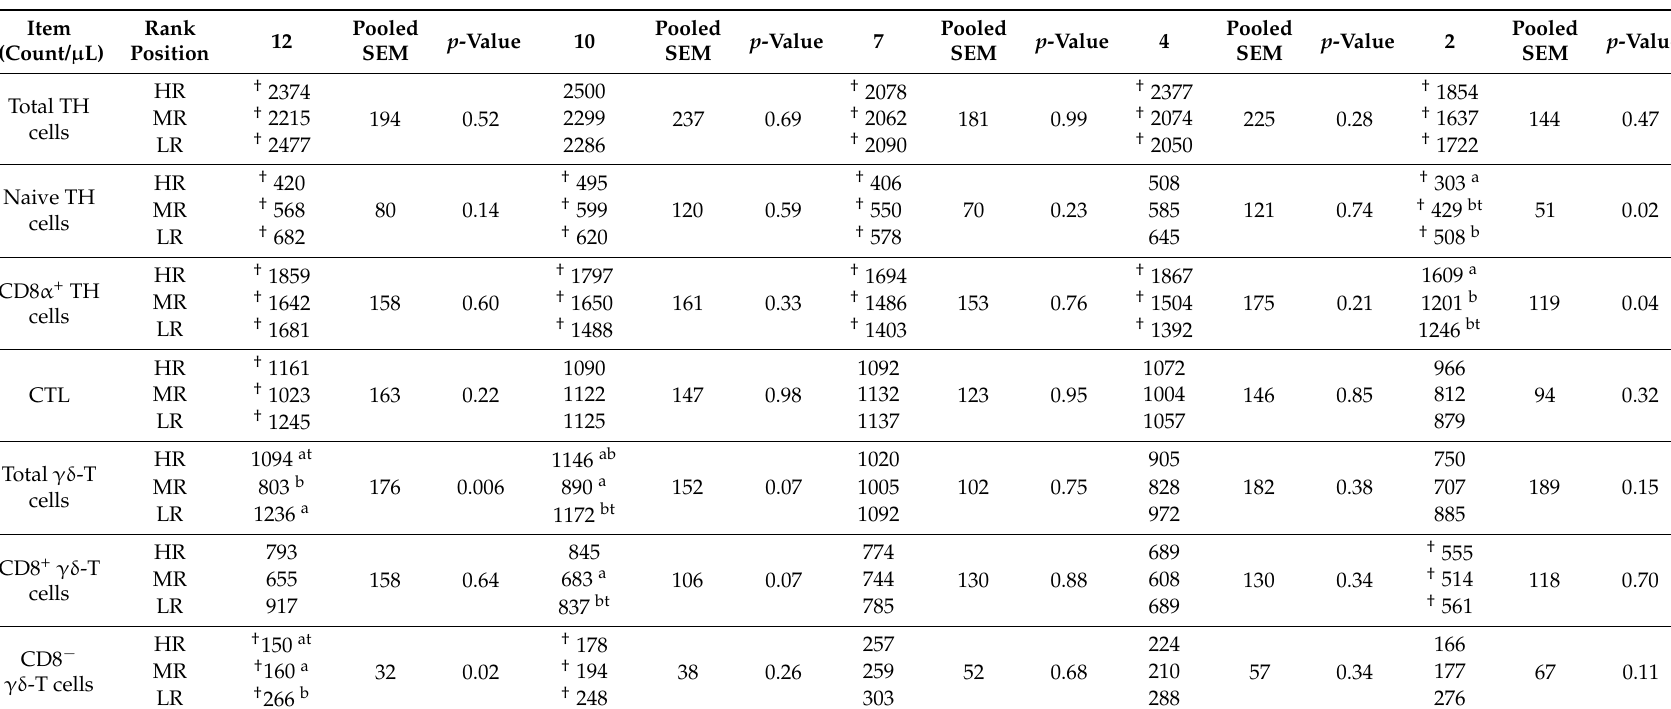
Table 4. Influence of social rank on the count of blood T cell subpopulations in high-ranking (HR), middle-ranking (MR), and low-ranking (LR) pregnant sows at defined weeks pre